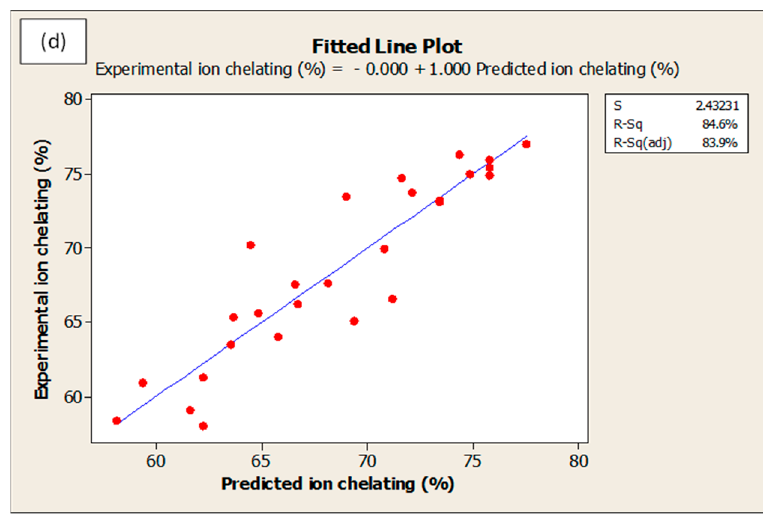
Figure 7. Fitted line plots for predicted and experimental values for ( a ) degree of hydrolysis, ( b ) ACE-inhibition, ( c ) DPPH • radical scavenging activity and ( d ) ferrous ion chelating activity. All values are reported in %.